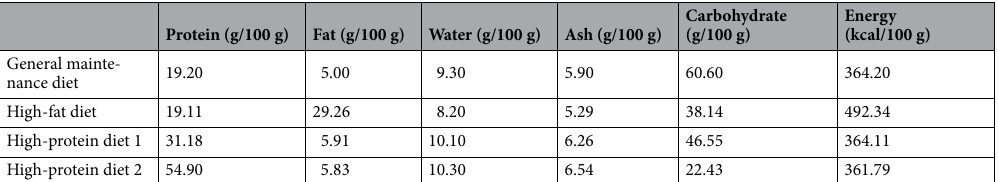
Table 2. Contents of main nutrients and energy in each diet.